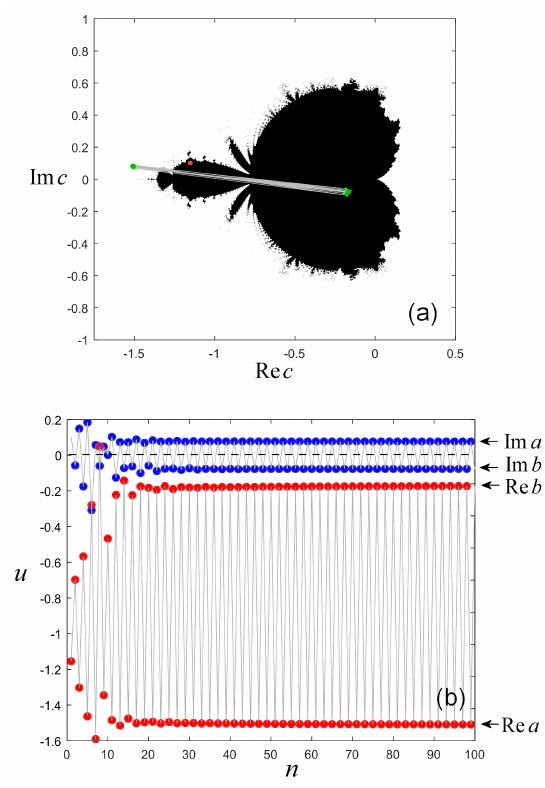
Figure 4. Asymptotic 2-periodic cycle of the FOM map for q = 0.75 and c = − 1.15481 + 0.102204 ı (red point): ( a ) Asymptotic 2-periodic cycle (green) overplotted over the FOM set; ( b ) Time series of the solution u , after 100 iterations: real component (red) and imaginary component